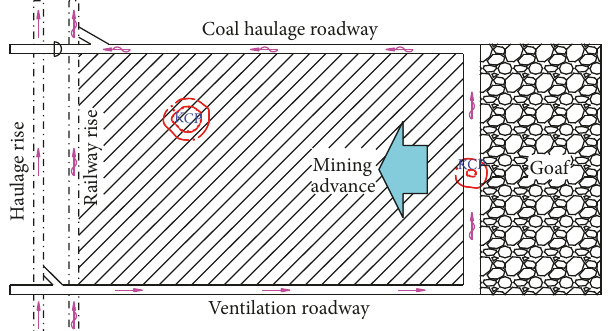
Figure 10: Illustration of number 10-106 longwall panel and KCP in Tuanbai coal mine of Shanxi province, China.